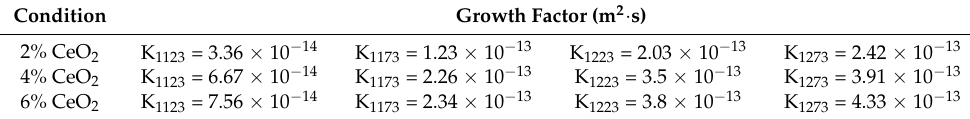
Table 7. Growth factors at different rare earth (CeO 2 ) contents.